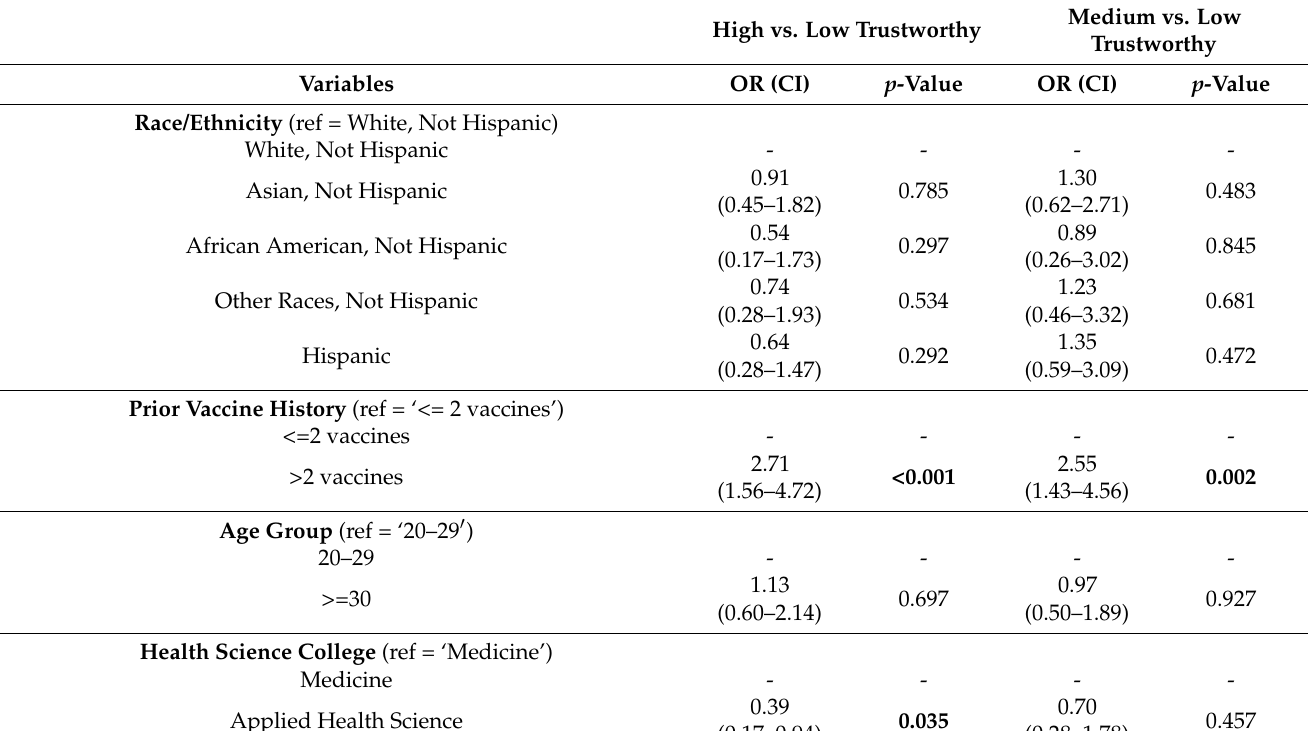
Table 6. Multinomial logistic regression on trustworthy scoring outcome. High vs. Low